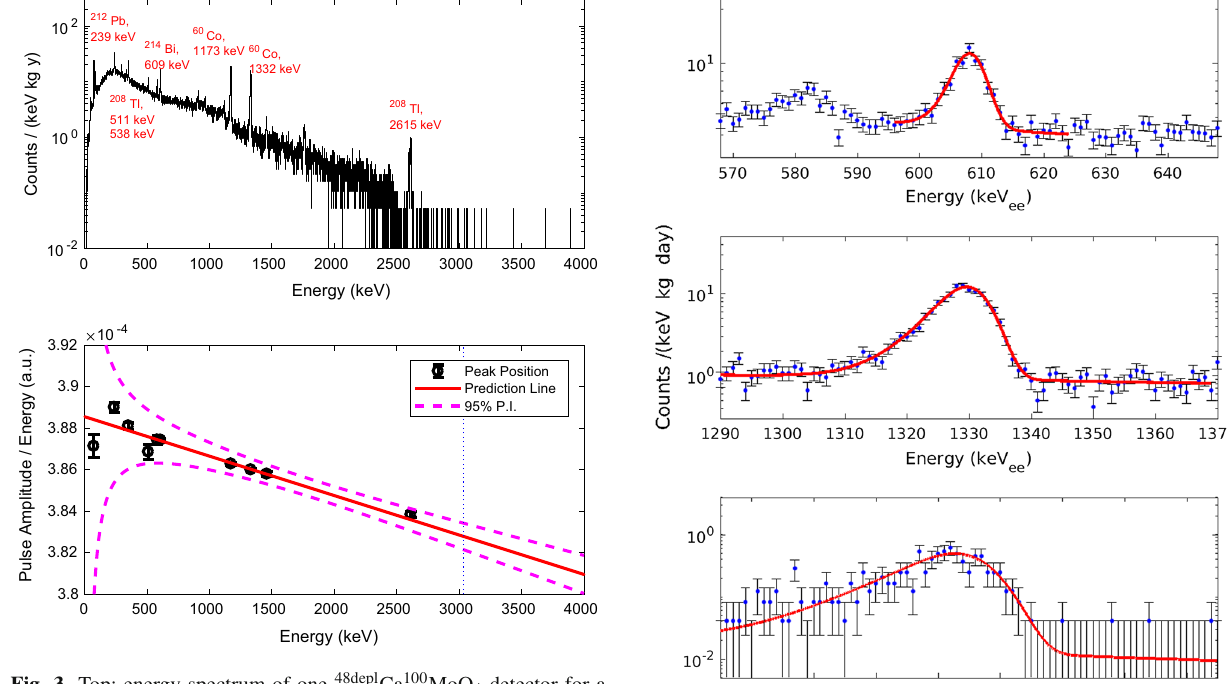
Fig. 3 Top: energy spectrum of one 48depl Ca 100 MoO 4 detector for a 60 day exposure after the application of the event selection criteria, without a calibration source. The most prominent γ peaks are labelled. Bottom: a second-order polynomial calibration curve (solid) with its 95%P.I.(dashed).Theverticaldashedlineinthebottomfigureindicates the Q value of 100 Mo double beta decay. See Sect. 4 for a detailed explanation of the event selection methods